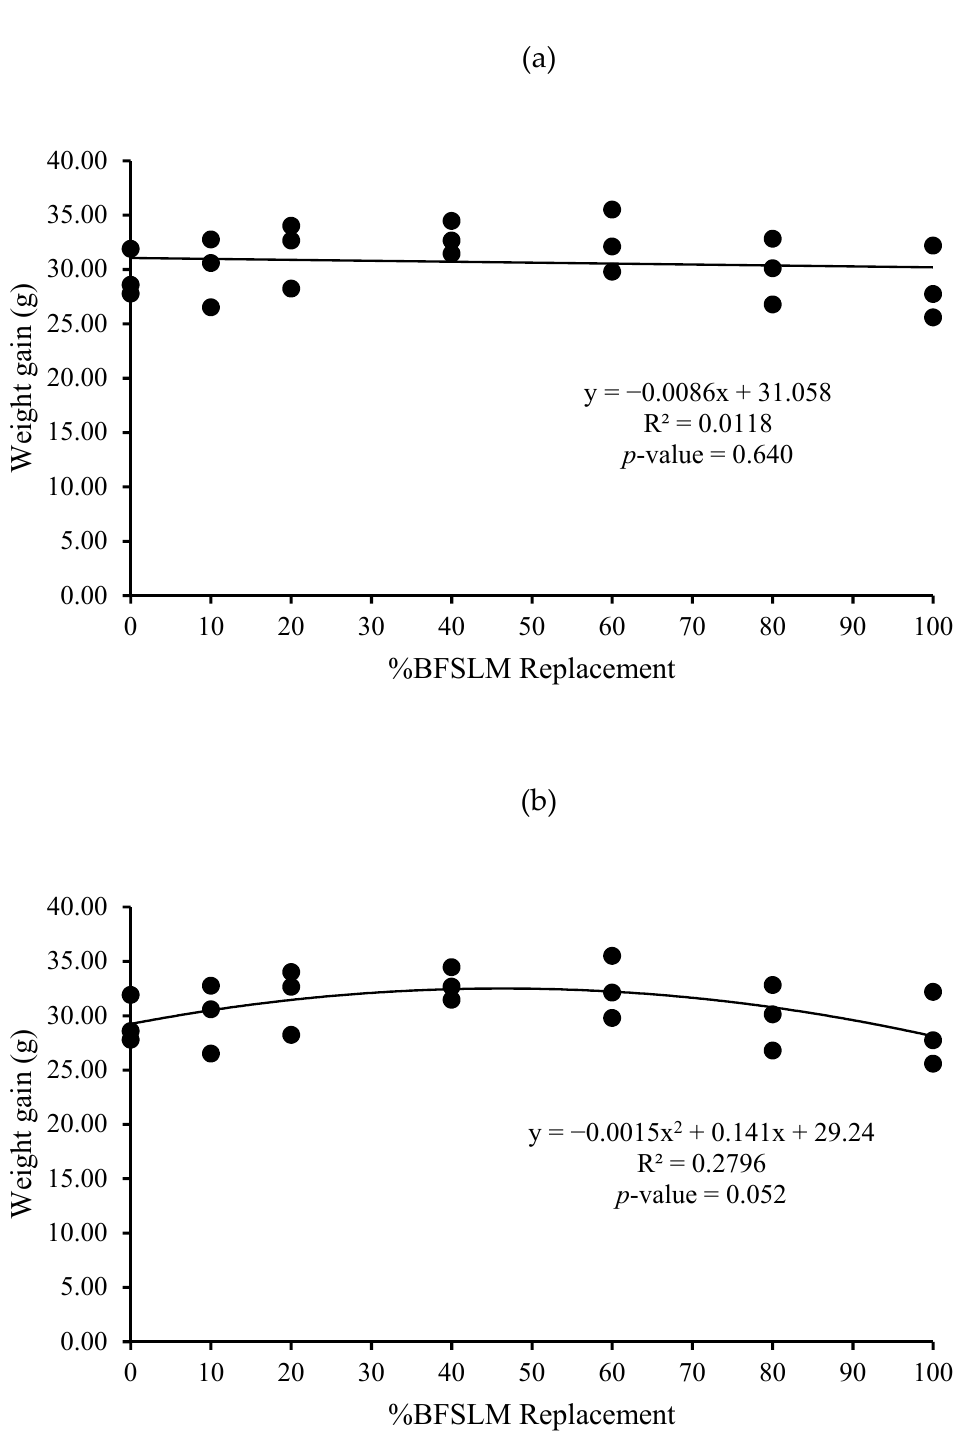
Figure 4. Linear ( a ) and quadratic ( b ) estimate: When X = %BSFLM replacement; Y = Weight gain after 12 weeks of feeding with control (0% BSFLM and 100% FM), and FM replaced at 10%, 20%, 40%, 60%, 80%, and 100% of the BSFLM.